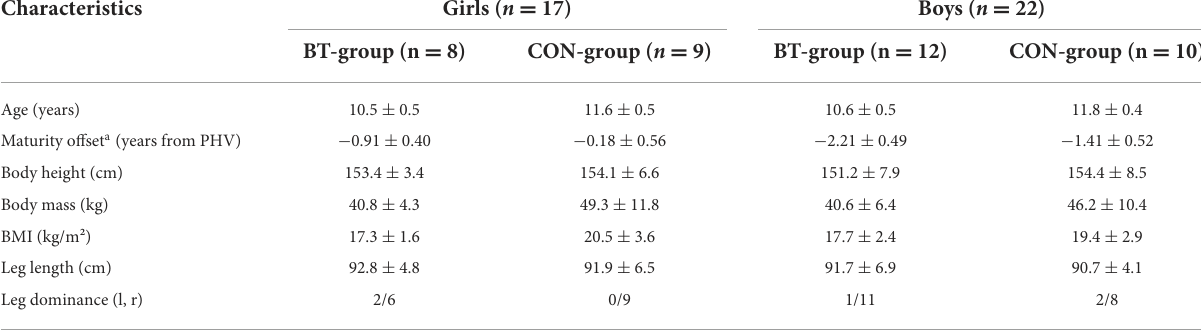
TABLE 1 Characteristics of the study participants ( N = 39).